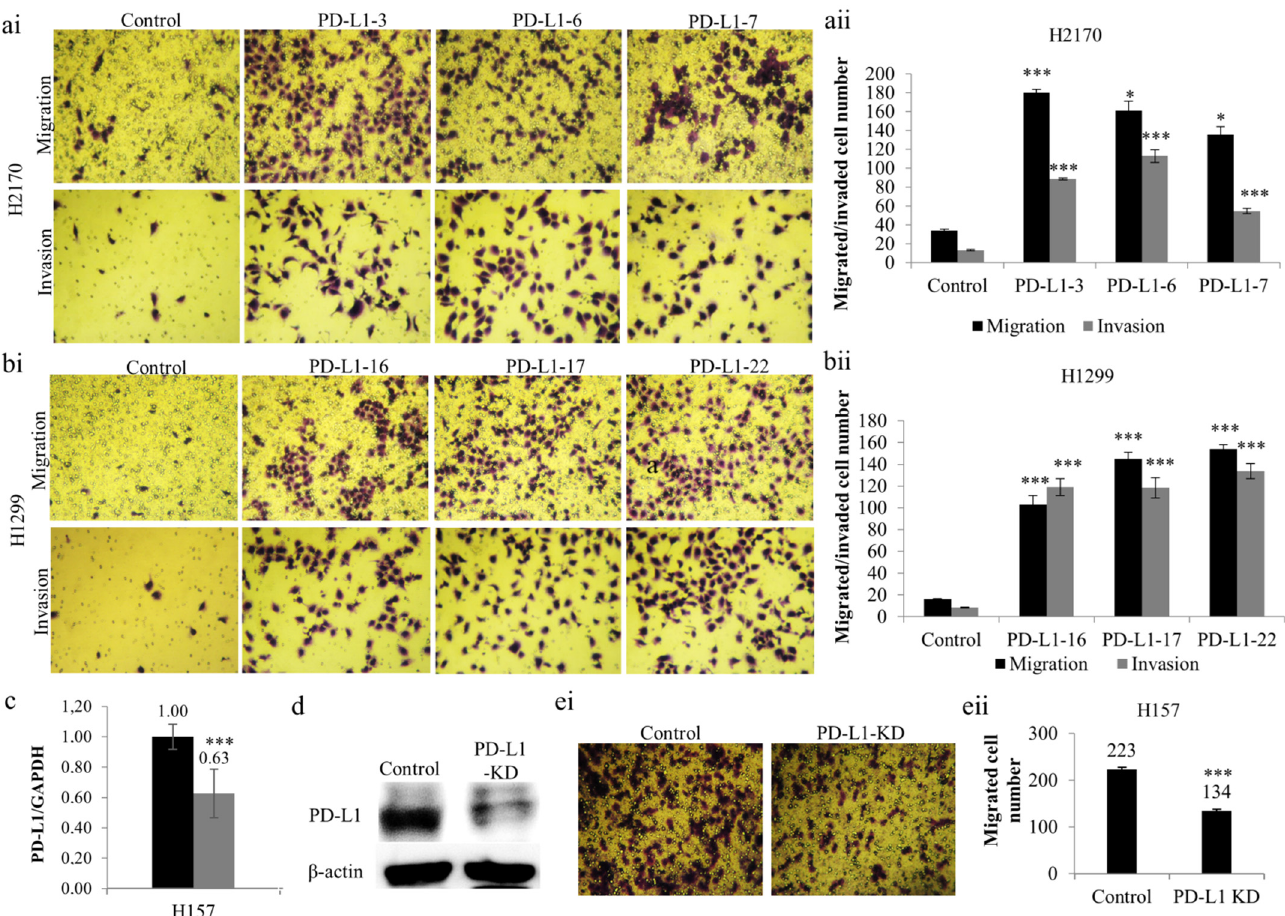
Figure 3. Effects of PD-L1 on NSCLC migration and invasion. Overexpression of PD-L1 enhanced the migratory and invasive ability of H2170 ( a ) and H1299 ( b ) cells. Representative images of the migration and invasion assays ( ai , bi ); magnification 50 ×); quantification of the number of migrated and invaded cells of H2170 ( aii) and H1299 (bii ). Reduced PD-L1 mRNA expression ( c ) and protein expression ( d ) in H157 cells after siRNA knockdown (KD). β -actin was used as a loading control for Western blotting (WB). ( e ) Knockdown of PD-L1 led to decreased migratory ability, revealed by migration assay. Representative images of the migration assay ( ei, magnification 50 × ); quantification of the number of invaded cells ( eii ). * p < 0.05, *** p < 0.001 when analyzed using Student’s t -test.